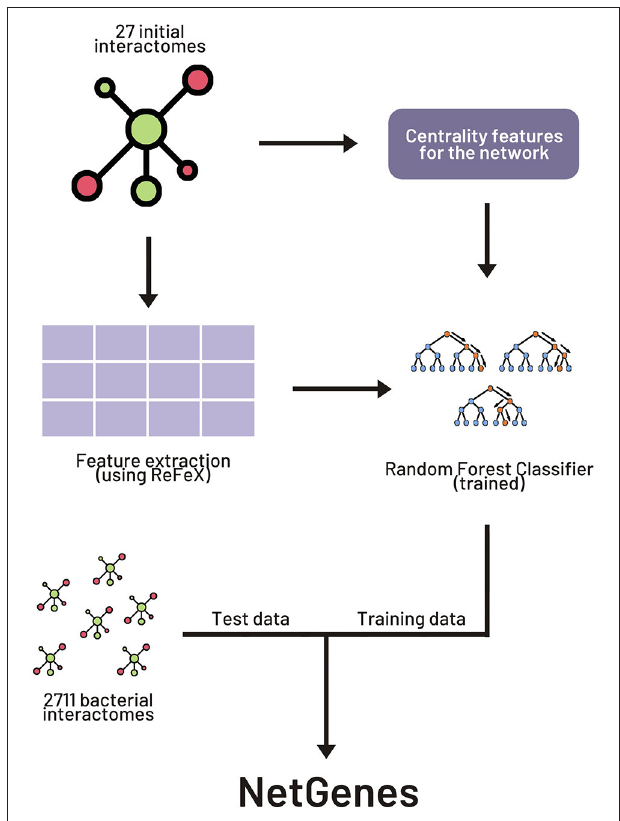
FIGURE 1 | Workflow for creating NetGenes database. The initial 27 interactomes were used as the training dataset to build the machine learning (ML) model. The 2711 interactomes were run through the ML model to obtain the essential gene predictions. These predictions are curated and published in the “NetGenes”